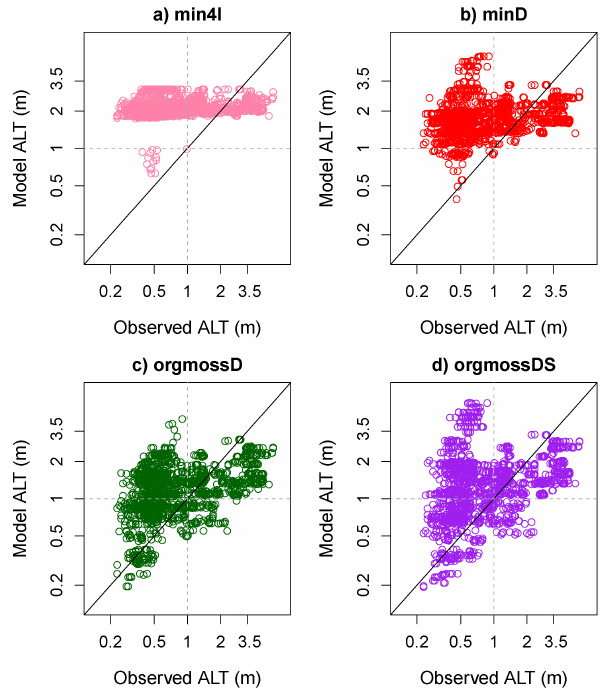
Figure 5. Active layer model values plotted against measurements from CALM data set (as in Fig. 4). The dashed lines show an ALT of 1m. Logarithmic axes are